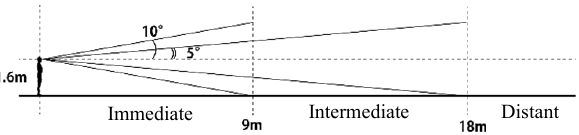
Figure 3 . Threshold settings for immediate, medium, and distant views.